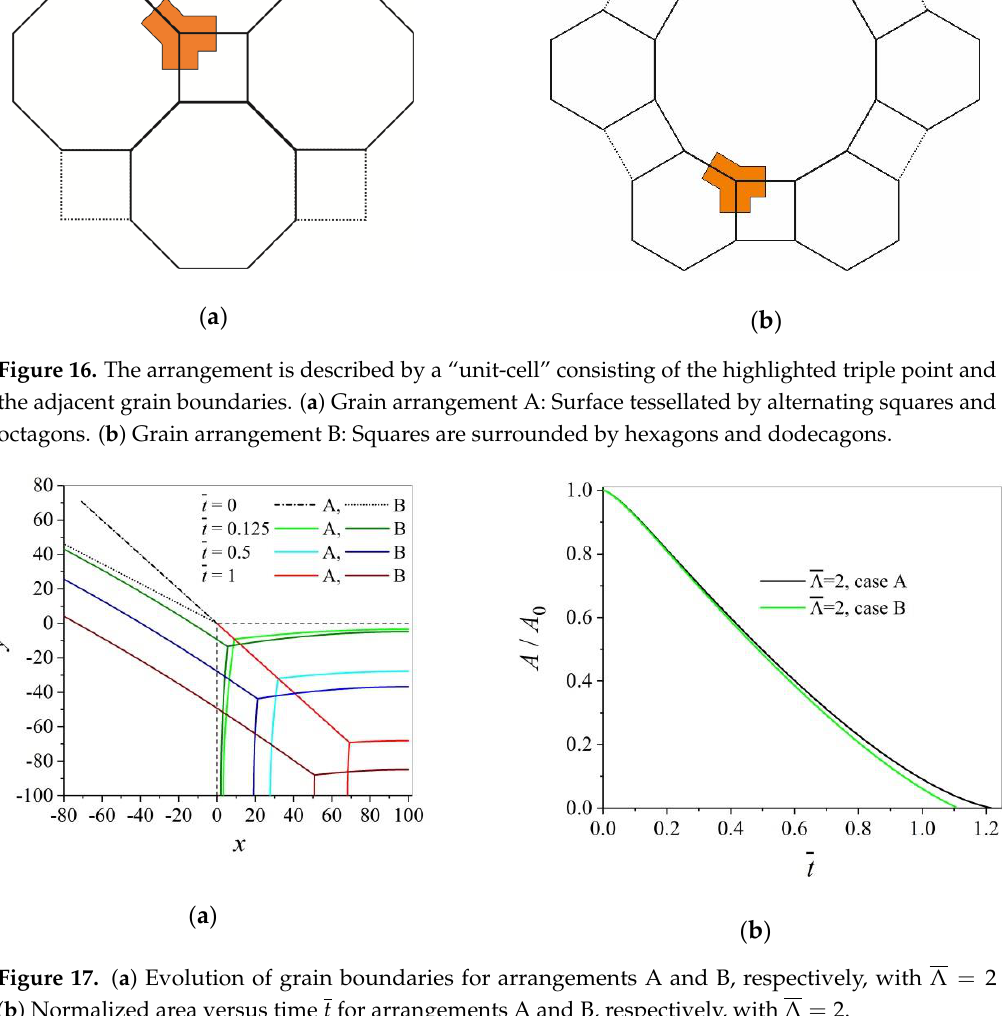
Figure 17. ( a ) Evolution of grain boundaries for arrangements A and B, respectively, with 2 = ( b ) Normalized area versus time t for arrangements A and B, respectively, with 2 = .